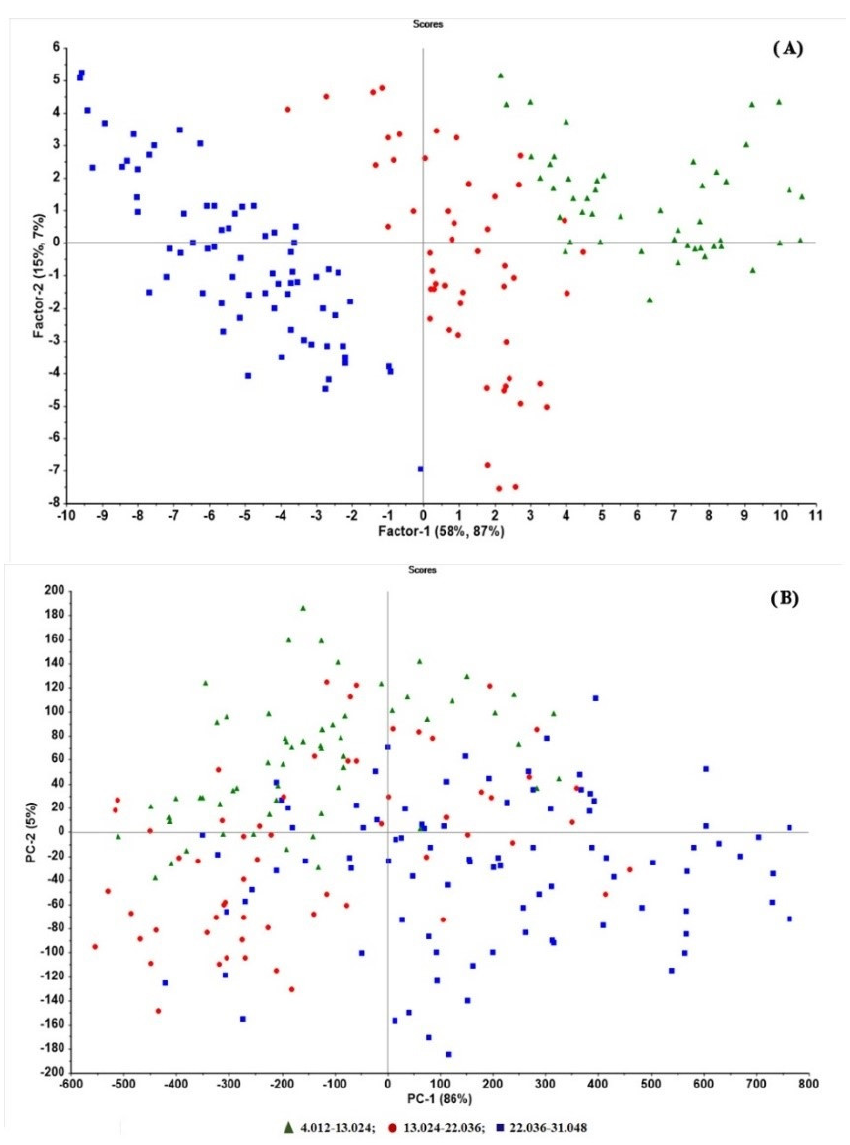
Figure 3. Score plots of ( A ) the pretreated data (area normalization and SNV) and ( B ) original data of the best model for tablets. The data grouping by concentrations along with PC1 was clearly seen from the pretreated data compared the original